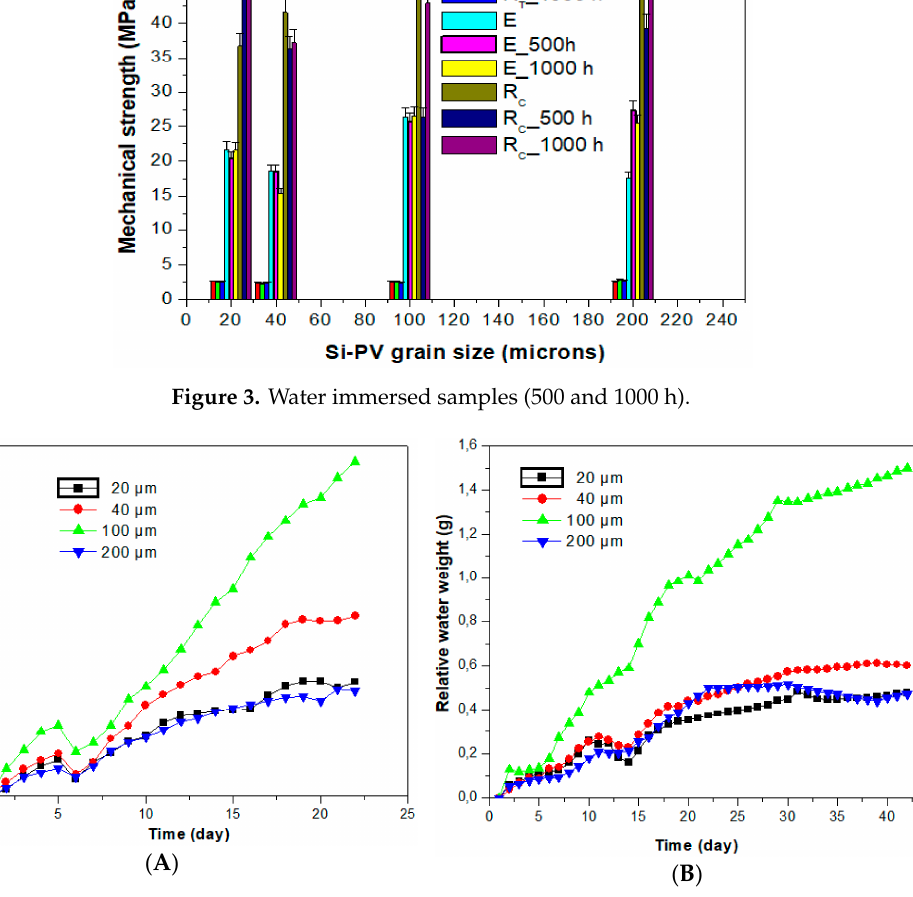
Figure 4. Relative absorbed water after ( A ) 500 h, ( B ) 1000 h.